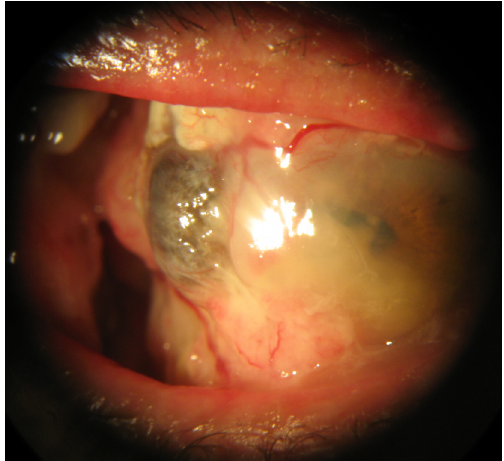
Figure 7: Tumor progression involving ocular globe tissues